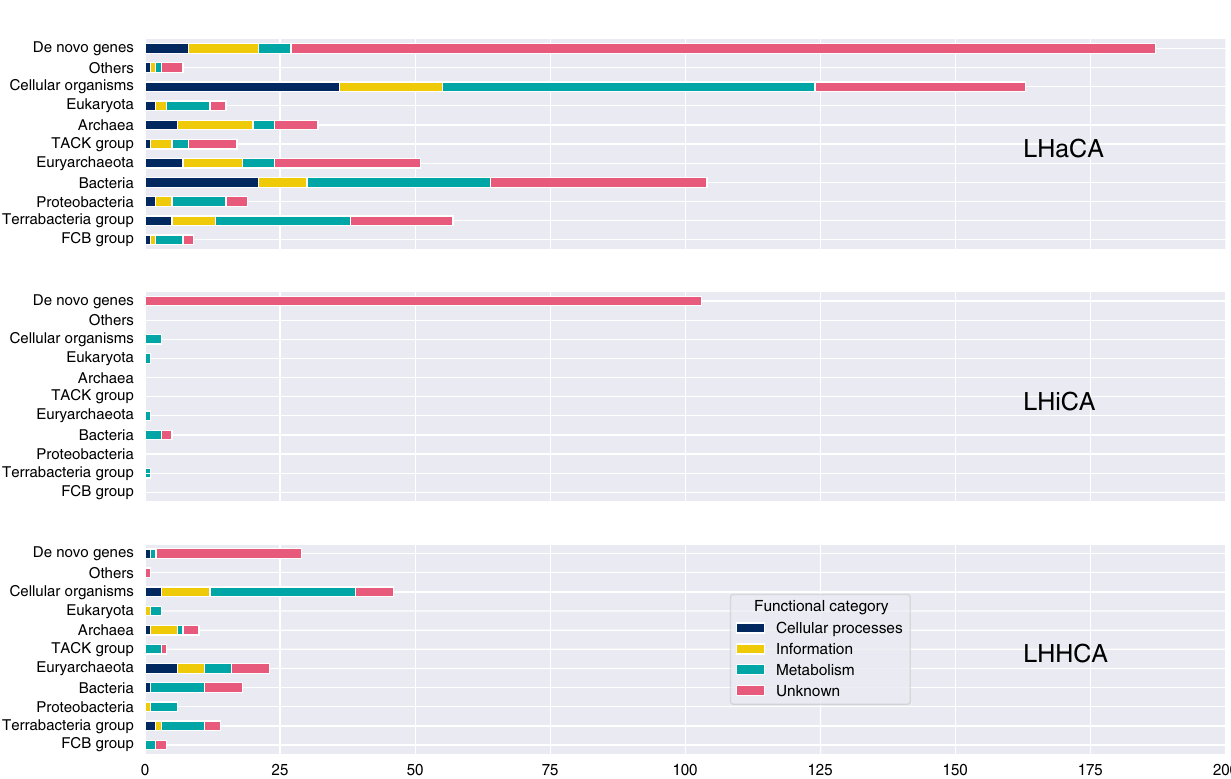
Fig. 5 Tracing the origins of haloarchaeal gene content. Stacked bar charts showing the inferred taxonomic af fi liation of originations at the LHaCA, LHiCA, and LHHCA. Each bar corresponds to an inferred taxonomic group, where the length of the bar indicates the number of clusters with that taxonomic annotation and the colors indicate the broad functional annotation of the clusters. For visualization purposes, we also summarized more speci fi c placements into broader taxonomic